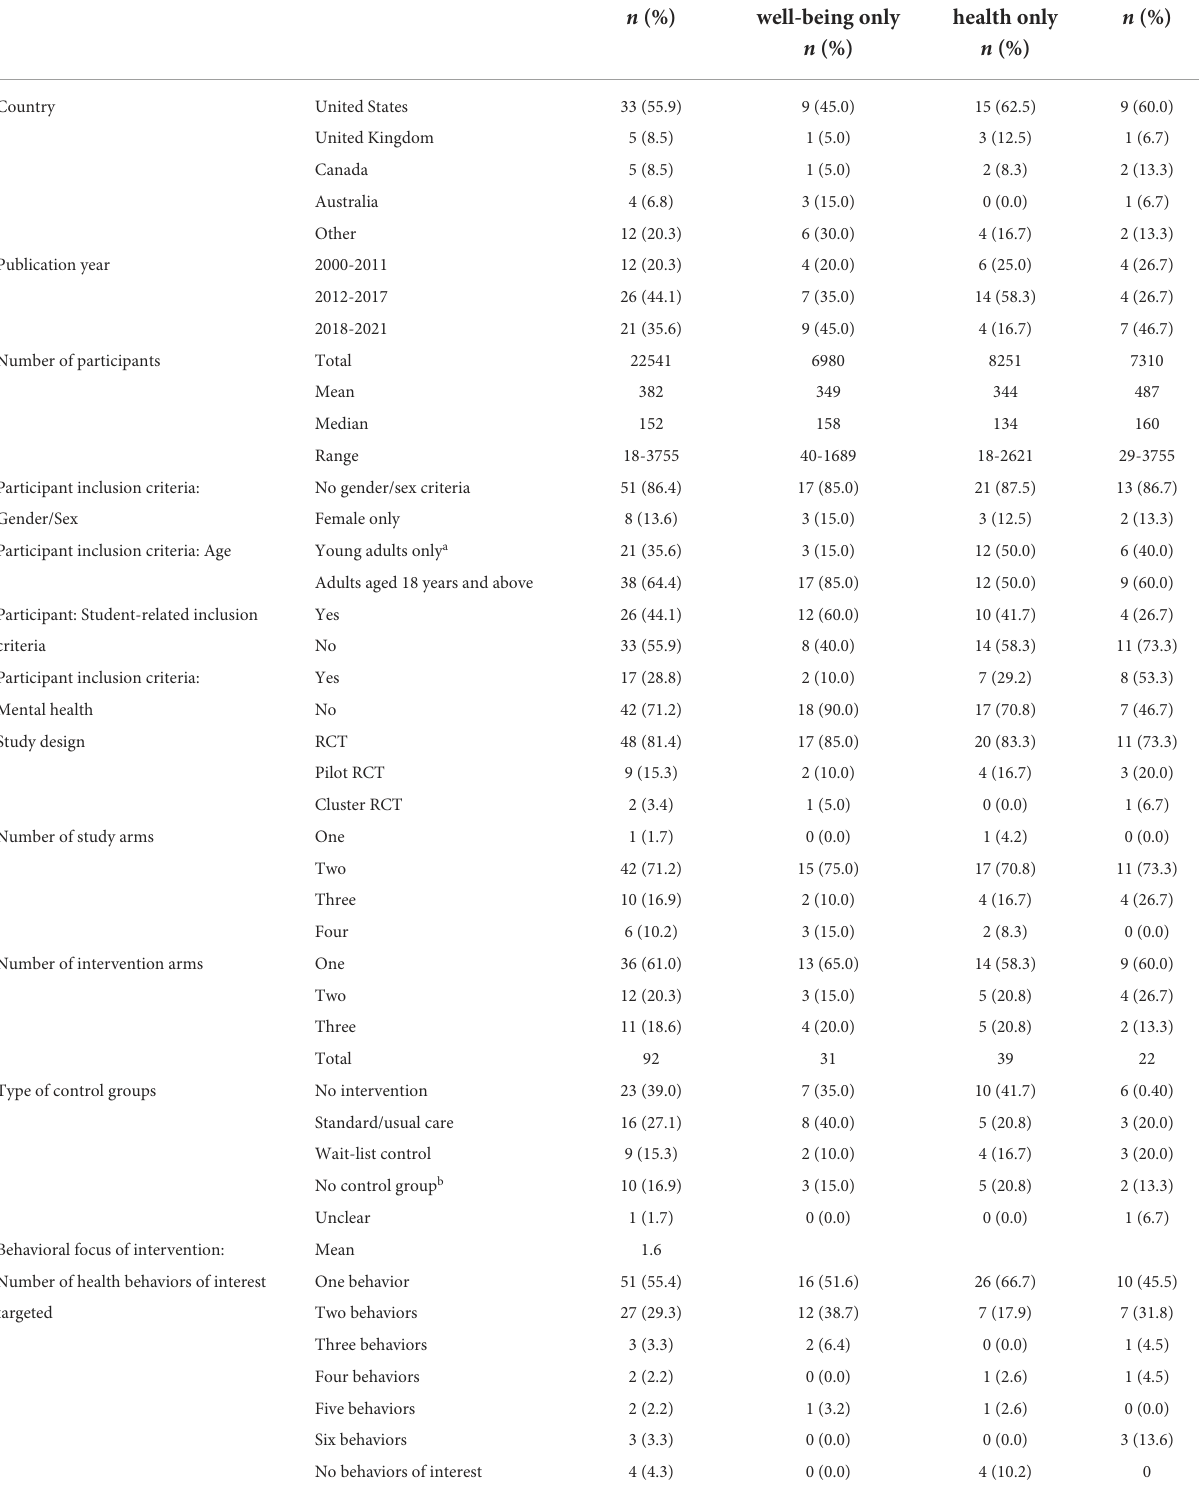
TABLE 1 Summary of study characteristics of 59 RCTs evaluating interventions targeting various health risk behaviors in university